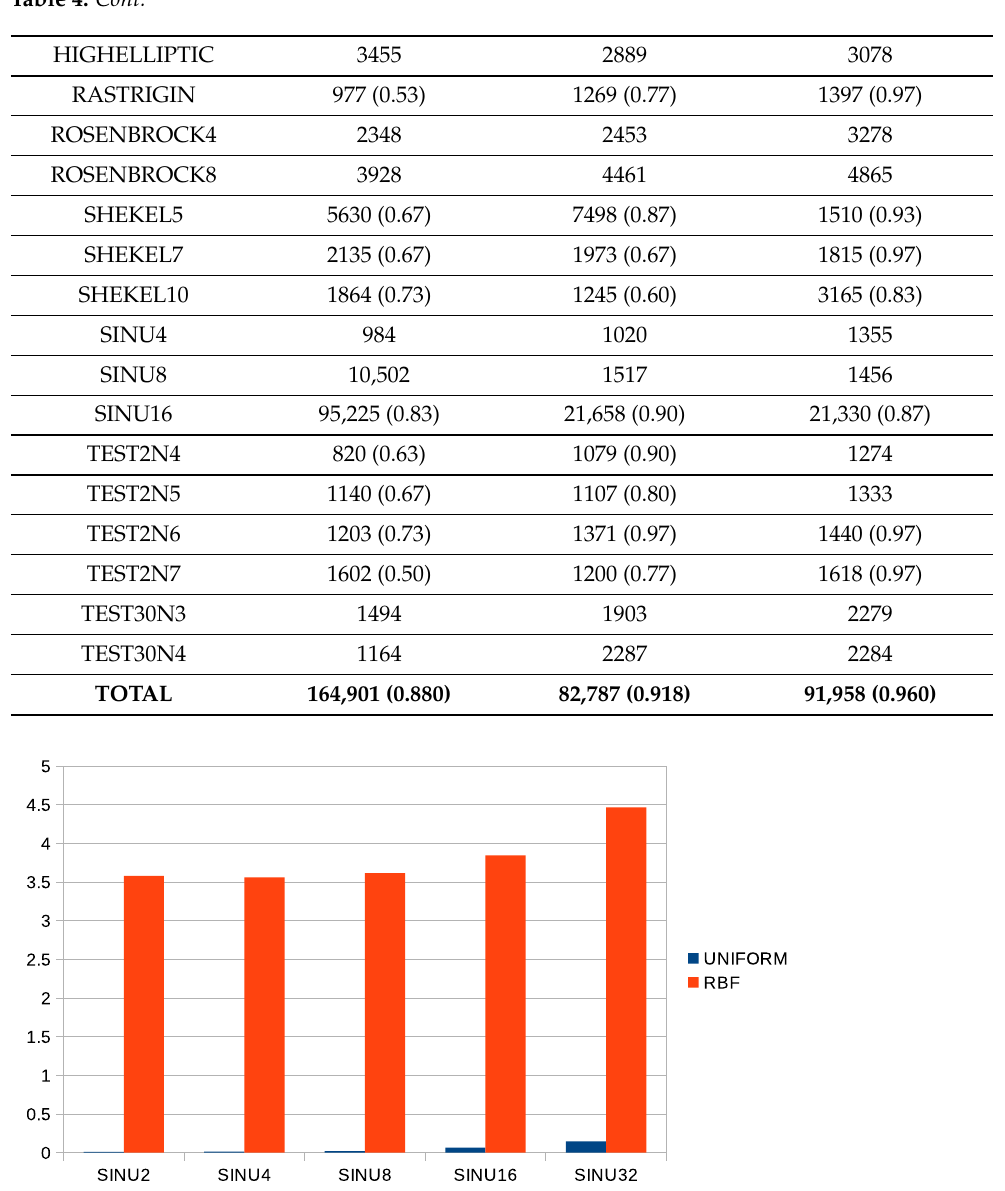
Figure 6. Comparison of execution times for the SINU function between the uniform sampling and the proposed